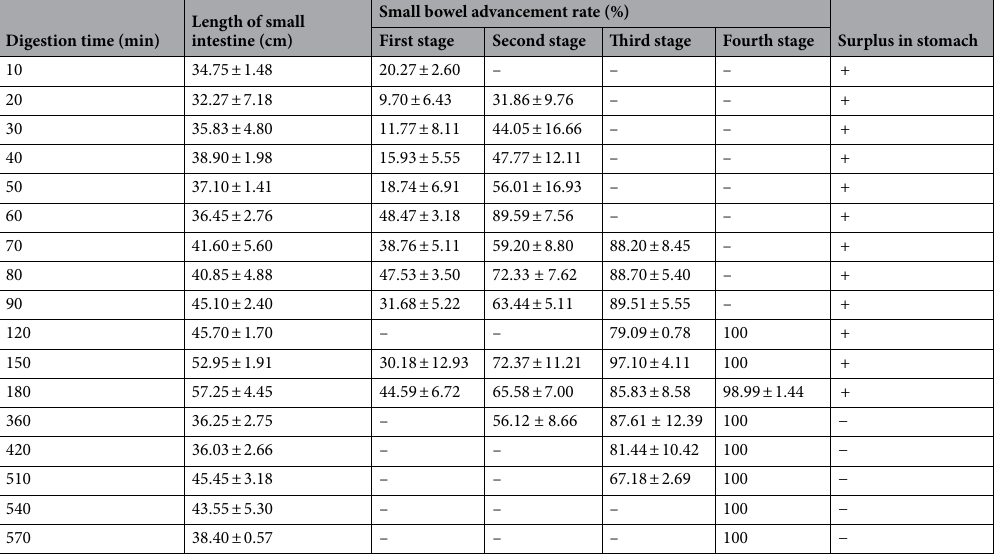
Table 3. Digestion time, length of small intestine and small bowel advancement rate of nutrient semi-solid paste in the GIT in mice. “+” Surplus in stomach. “–” None remaining in stomach.